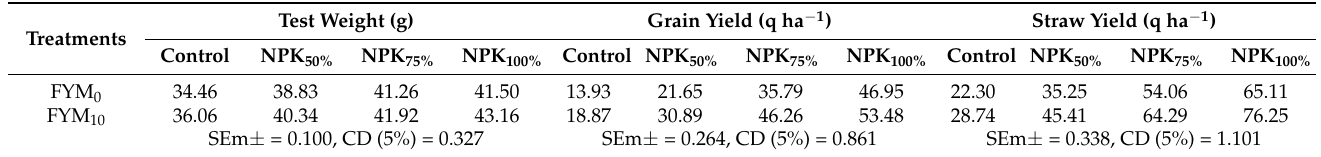
Table 4. Interaction effect of fertility levels and FYM on the yield attributes and yield of wheat (mean data of two years).